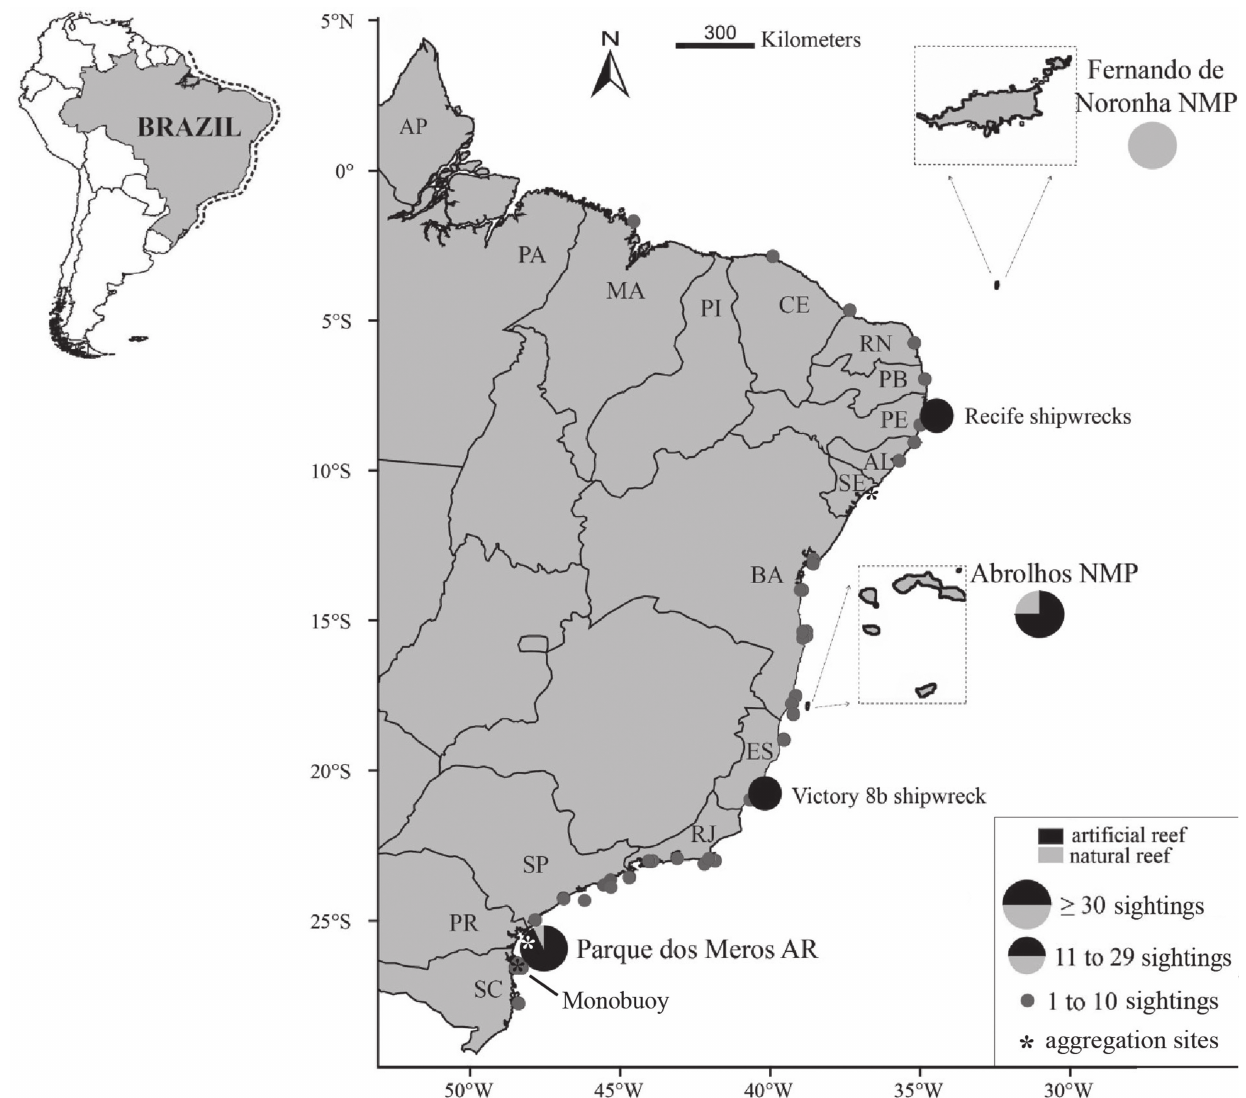
Fig. 1. Sightings of Epinephelus itajara along Brazilian coast. States: South: SC = Santa Catarina; PR = Paraná. Southeast: SP = São Paulo; RJ = Rio de Janeiro; ES = Espírito Santo. Northeast: BA = Bahia; SE = Sergipe; AL = Alagoas; PE = Pernambuco; PB = Paraíba; RN = Rio Grande do Norte; CE = Ceará; PI = Piauí; MA = Maranhão. North: PA = Pará and AP = Amapá. NMP = National Marine Park; and AR = artificial